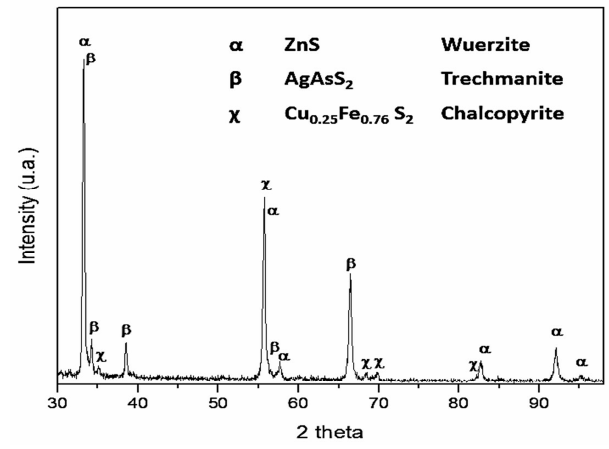
Figure 1. X ‐ ray diffractogram of the powder of pull size concentrate of Zn. Figure 1. X-ray diffractogram of the powder of pull size concentrate of